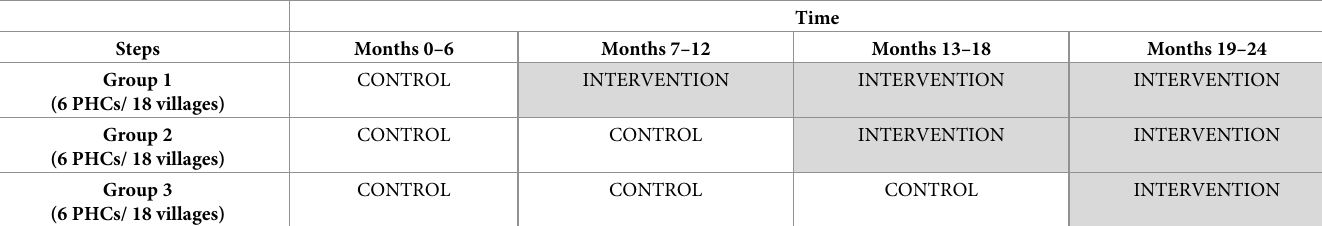
Table 1. Stepped wedge allocation sequence.